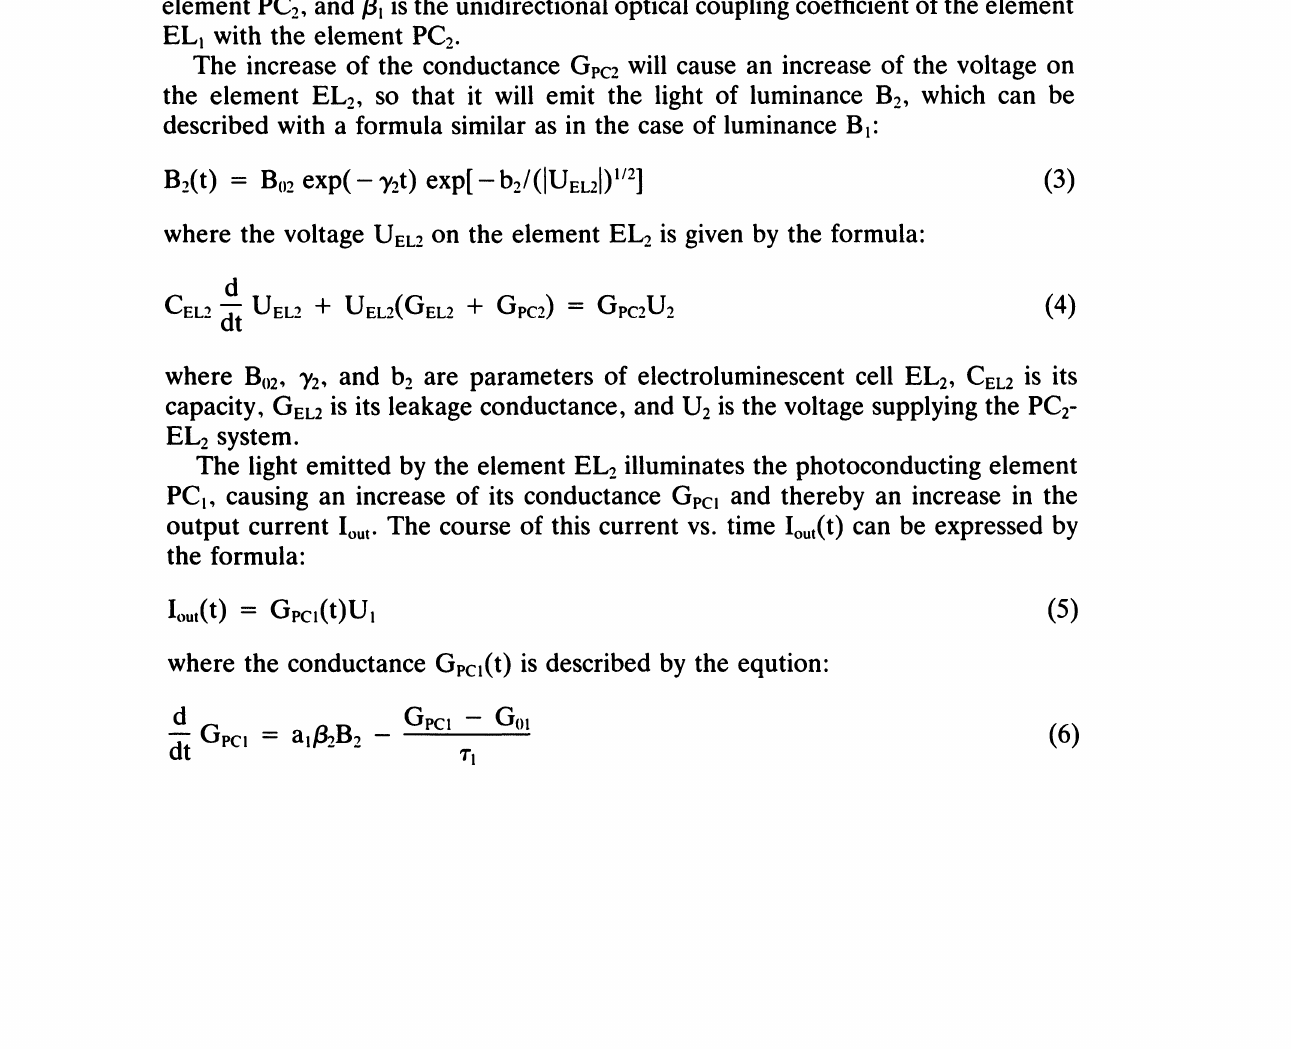
EL PC 2 2 PC-EL type electric signal delaying